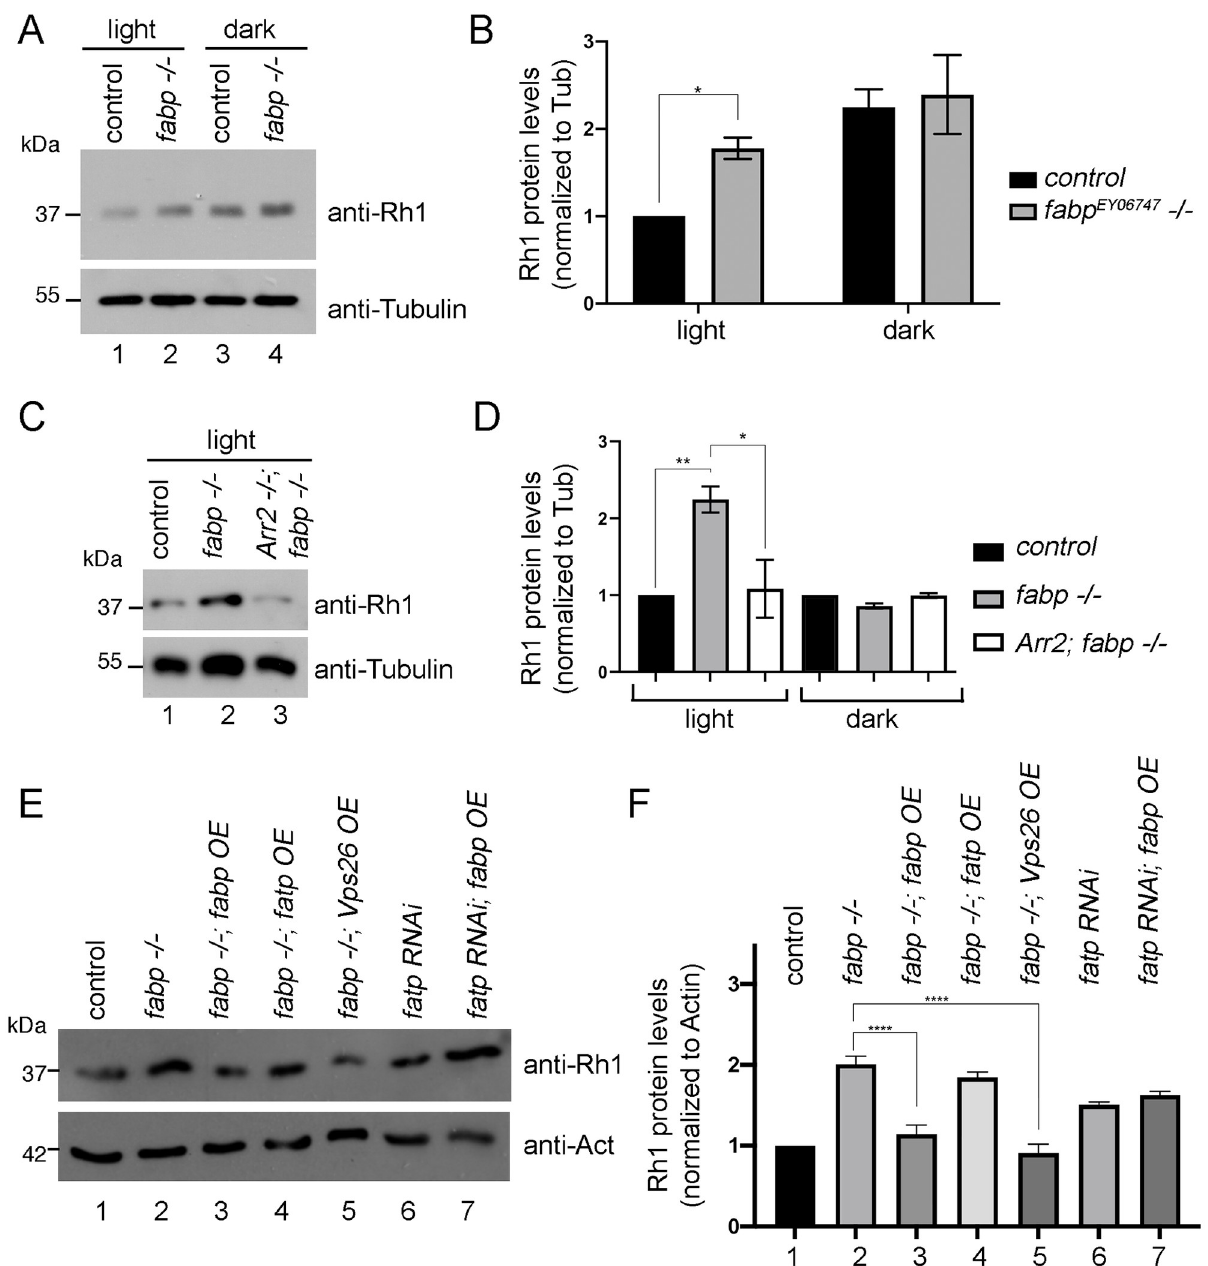
Fig 5. fabp genetically interacts with Arrestin2 and Vps26 in regulating Rh1 levels in response to light exposure. (A) An anti-Rh1 western blot of control fabp wild type (lanes 1, 3) or fabp EY02678 -/- (lanes 2, 4) fly head extracts. The flies were either reared under constant light (lanes 1, 2) or in constant darkness (lanes 3, 4). The lower band shows an anti- β -Tubulin blot as a control. (B) Quantification of anti-Rh1 blot intensities, normalized to anti- β -Tubulin blots. Statistical significance was assessed through a two tailed t-test. � = p < 0.05. (C) Rh1 protein increase in fabp requires Arrestin2 . Shown are western blots for anti-Rh1 (top gel) and anti- β -Tubulin (bottom) from fly head extracts of control fabp wild type (lane 1), fabp EY02678 (lane 2), Arrestin2 3 ; fabp EY02678 double mutant flies (lane 3). The flies were reared under constant light before being analyzed. (D) Quantification of the normalized anti-Rh1 blot intensities. Left three bars are from flies reared under constant light. The right three bars are results from those reared in constant darkness. Two tailed t-tests. � = p < 0.05. �� p < 0.005. (E, F) Genetic interaction between fabp and Vps26 in regulating Rh1 levels. Flies were reared under constant light prior to analysis. (E) Western blots of anti-Rh1 (top) and anti-Actin (bottom). OE indicates Over Expression of the indicated genes through the GMR-Gal4 driver. RNAi knockdown was also performed using this Gal4 driver. (F) fabp EY06747 -/- samples had higher Rh1 levels compared to controls (compare lanes 1 and 2). Overexpression of either fabp (lane 3) or Vps26 (lane 5) in the fabp EY06747 -/- background suppressed such increase in Rh1 levels. Fatp RNAi also led to an increase in Rh1 levels (lane 6), but such effect was not suppressed by fabp overexpression (lane 7). Statistical significance was assessed through one way ANOVA with multiple comparisons test (compared to fabp EY06747 -/- ). ���� = p <